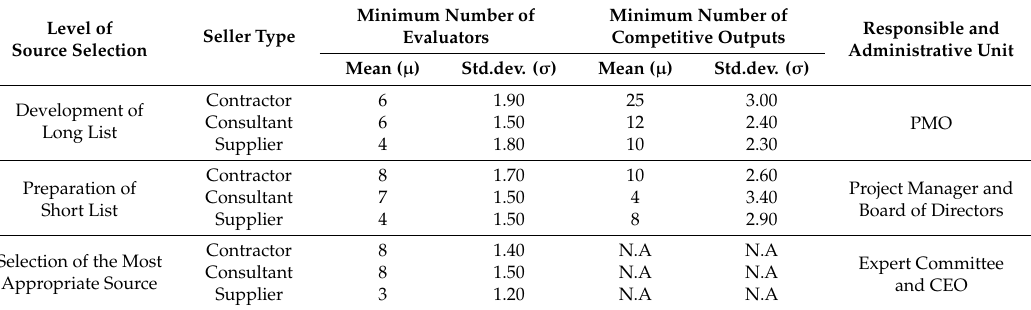
Table 3. Minimum number of evaluators, Minimum number of available sources in each level and responsible / administrative unit.